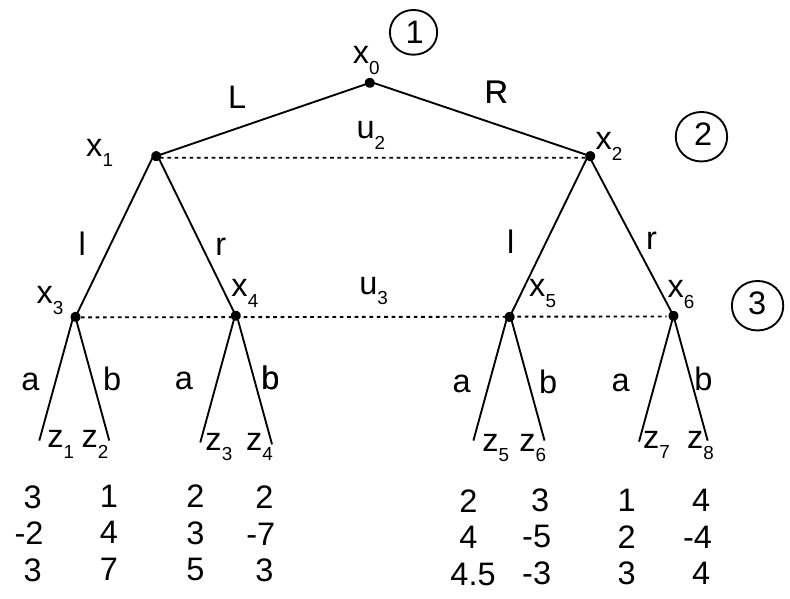
Figure 8. Thought process does not